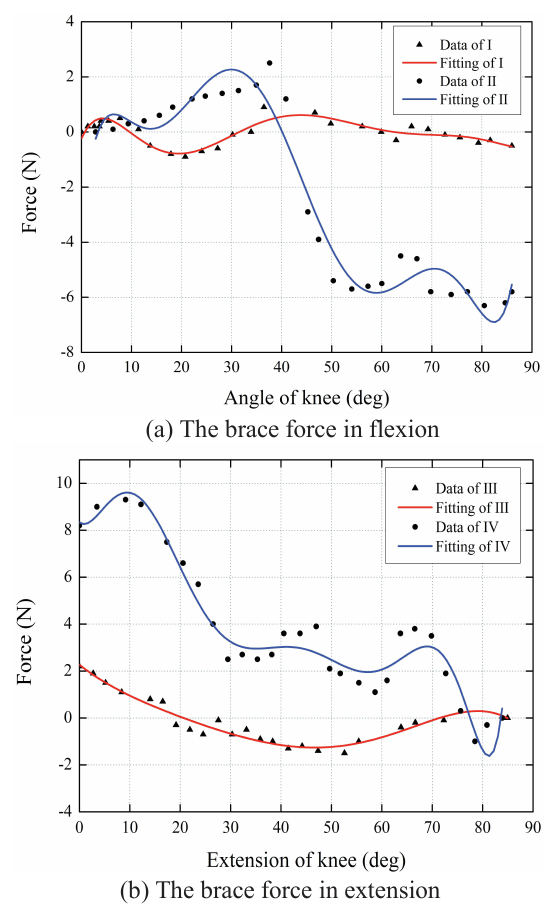
Figure 11. Performances comparison in